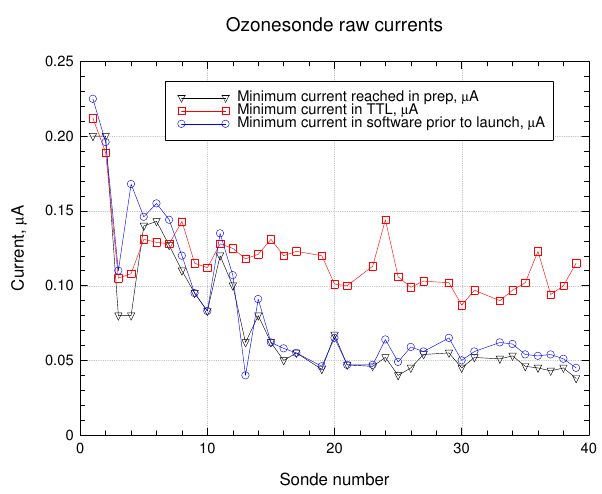
Figure 2. Values of background current measured at the beginning and end of the day-of-flight preparation (black and blue respec- tively) and the minimum current measured in the TTL during flight for the 34 successful